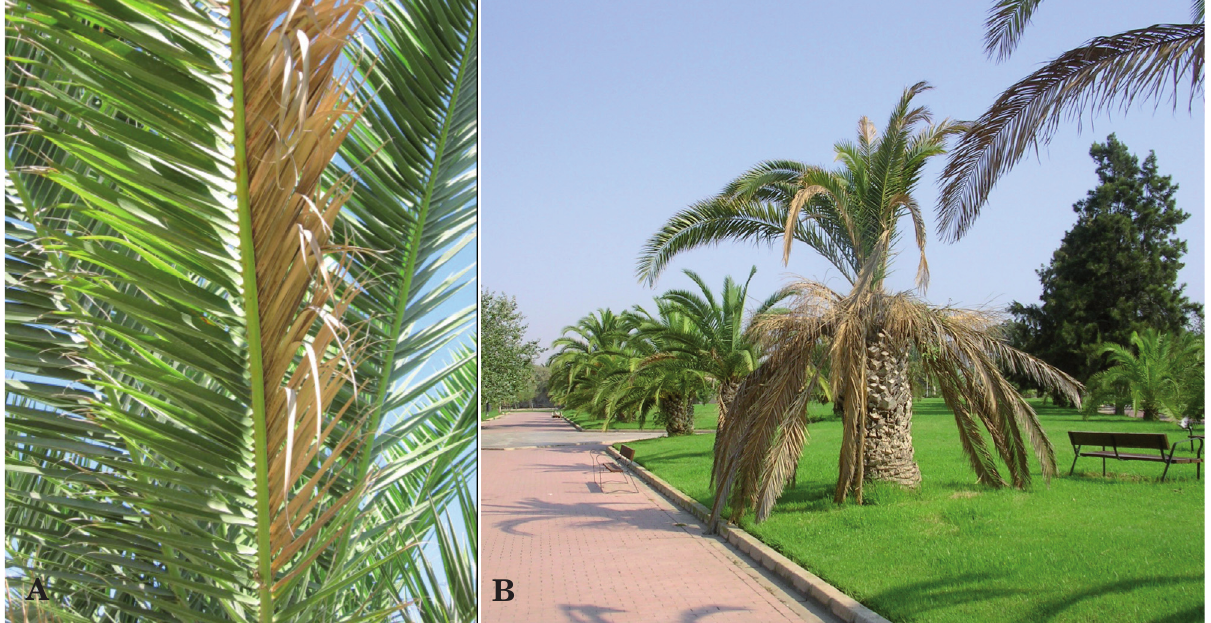
Figure 1. A. Characteristic asymmetrical wilt of the leaflets in just one side of the rachis in Phoenix canariensis. B. Severe wilt symptoms of a P. canariensis palm tree in a